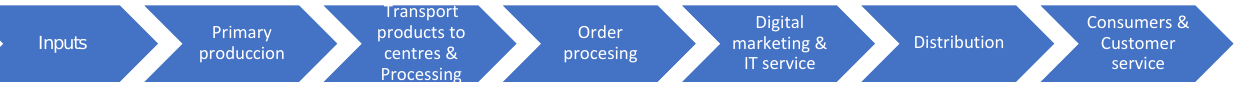
Figure 1. Stages identified in SASC.